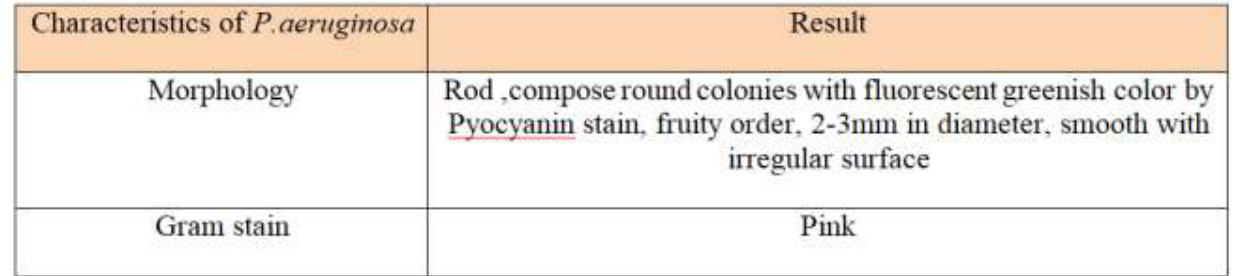
Table 1: Characteristics of P.